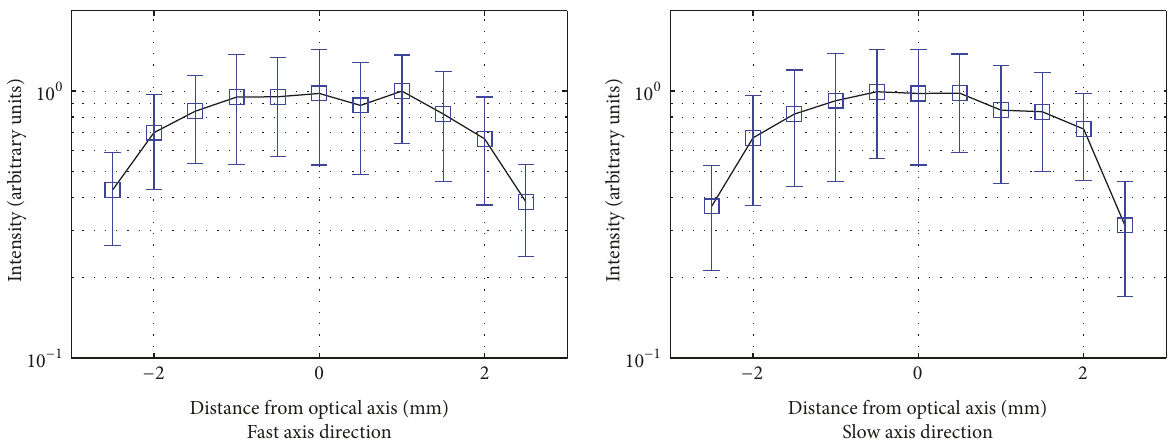
Figure 9: Variation in the intensity of OCT images across the field of view. At the borders of our field of view (4.7 mm in diameter), the intensity drops rapidly.